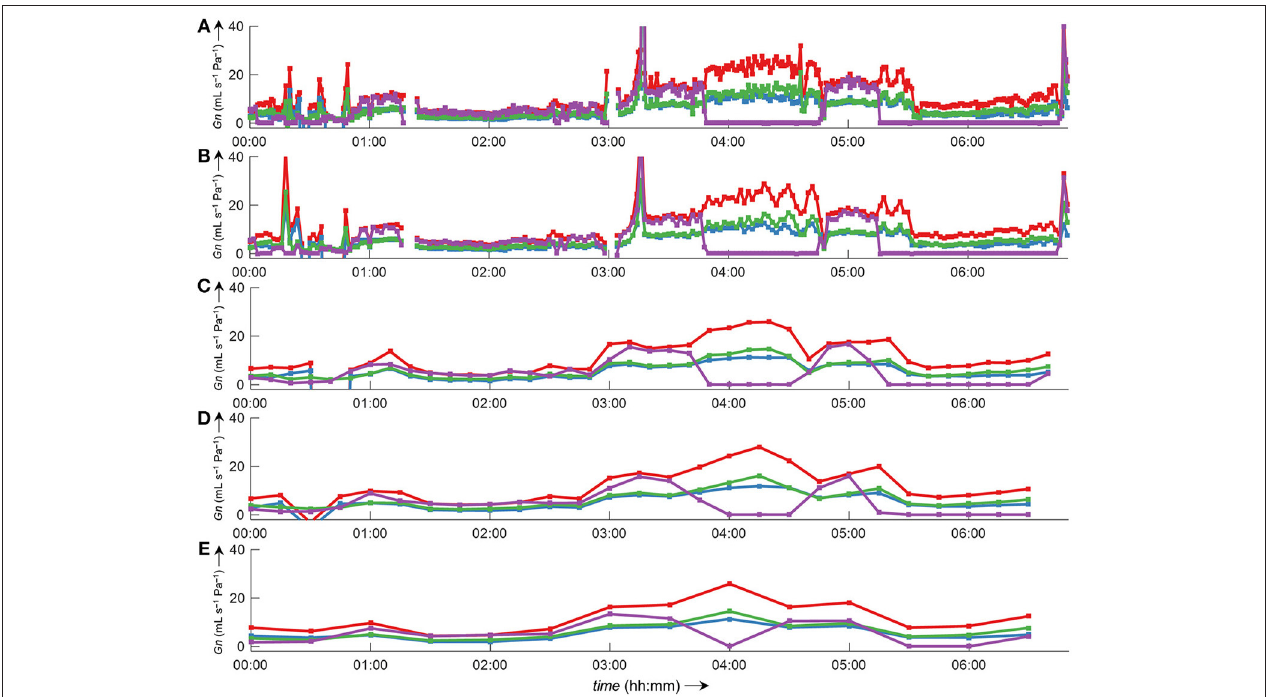
FIGURE 10 | Bilateral pressured-derived conductance curves obtained by conductance algorithm 3 in comparison to conductance obtained from a flow meter during a 7h overnight measurement evaluated for different consecutive time intervals. Overlay of left conductance ( Gn L , blue line), right conductance ( Gn R , green line), total conductance ( Gn L R , red line), and conductance derived from a flow meter ( Gn PNT , purple line). The conductance was evaluated as an average value for different + time intervals according to formula 3 ( Table 1 ): (A) , 1-min intervals; (B) , 2-min intervals; (C) , 10-min intervals; (D) , 15-min intervals; (E) , 30-min intervals. Values of zero conductance of Gn PNT are attributed to mouth breathing or mask leaks. Outliers and gaps in the curves (missing conductance values) result from processing